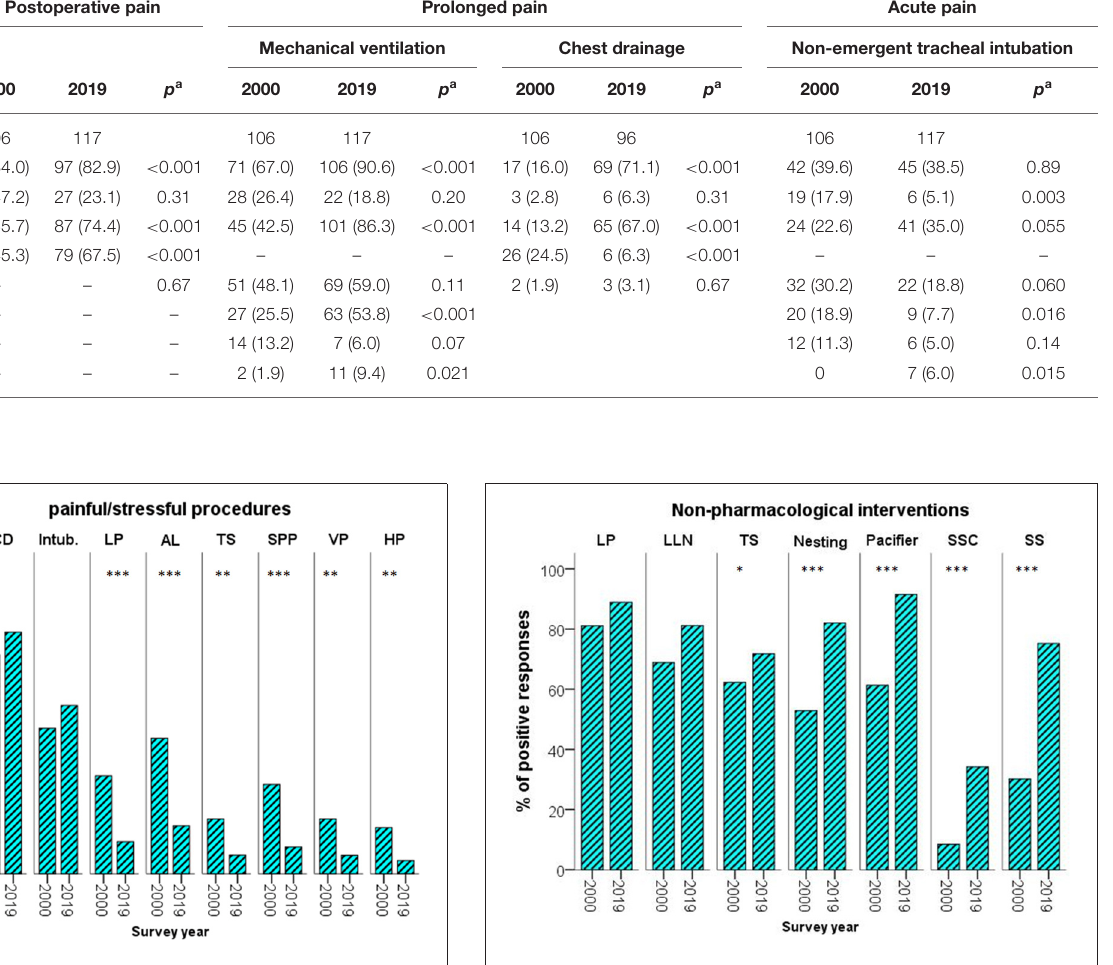
FIGURE 2 | Percentage of the respondents using non–pharmacological measures at the two time-points. LLN, low light & noise; LP, less procedures; SS, sweet solutions; SSC, skin-to-skin care; TS, tactile stimulations; * p < 0.05; *** p <